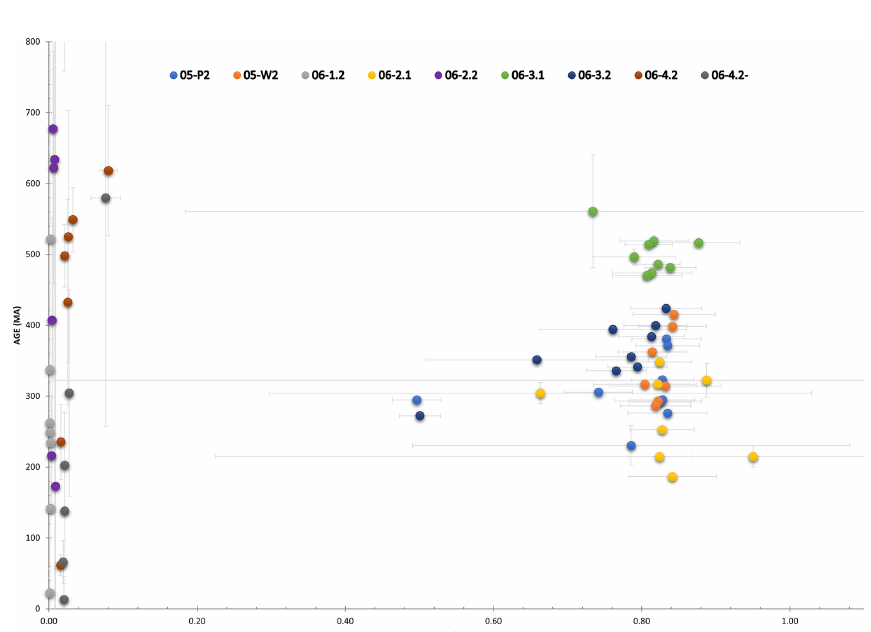
Figure 4. Measured age vs. K / Ca plot displaying two distinct populations within the samples tested.